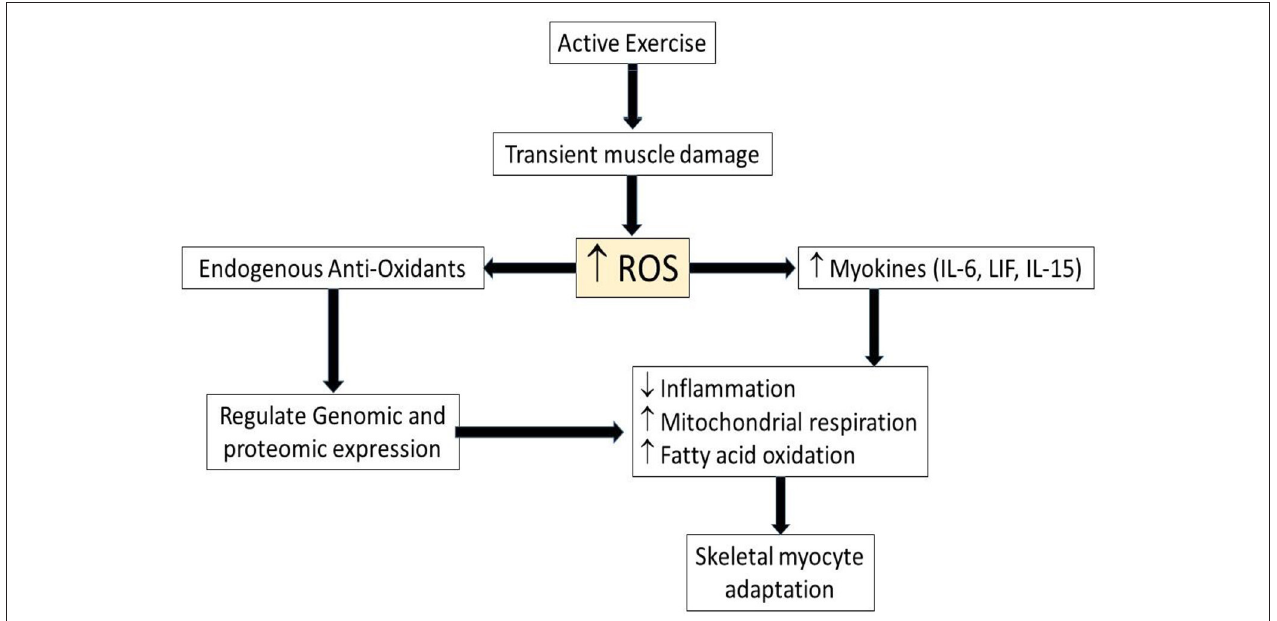
FIGURE 1 | Schematic illustrating role of ROS and myokines in myocyte adaptation during active exercise. Upwards arrows indicate increased level of parameters while downwards arrow indicates decreased level of parameter. ROS, Reactive oxygen species; IL-6, interleukin-6, LIF, leukemia inhibitory factor; IL-15,